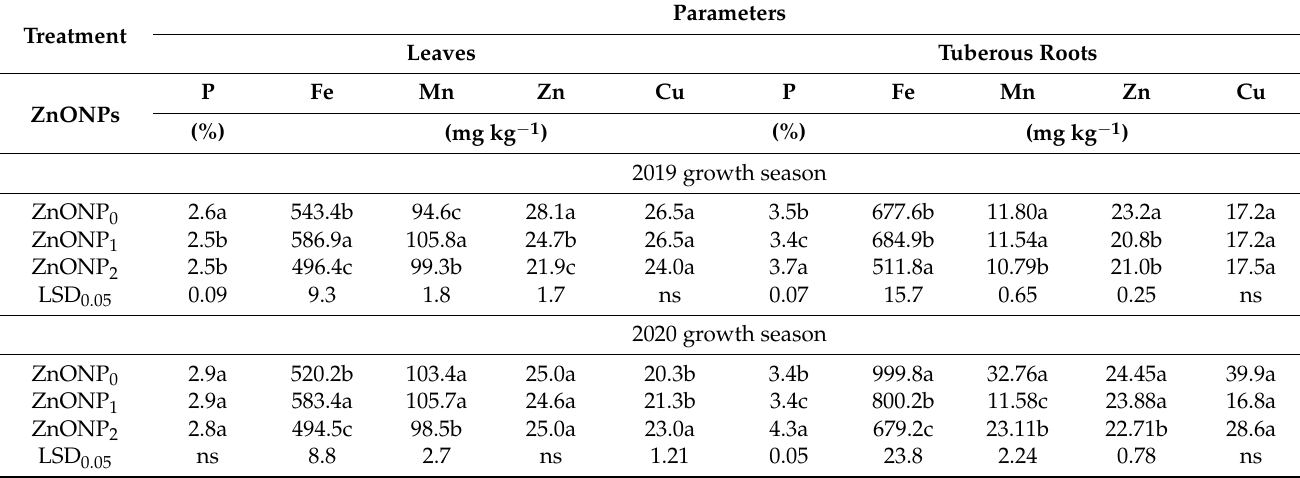
Table 4. Influence of zinc oxide nanoparticles on leaves and tuberous root nutrients content of stressed sweet potato in 2019 and 2020